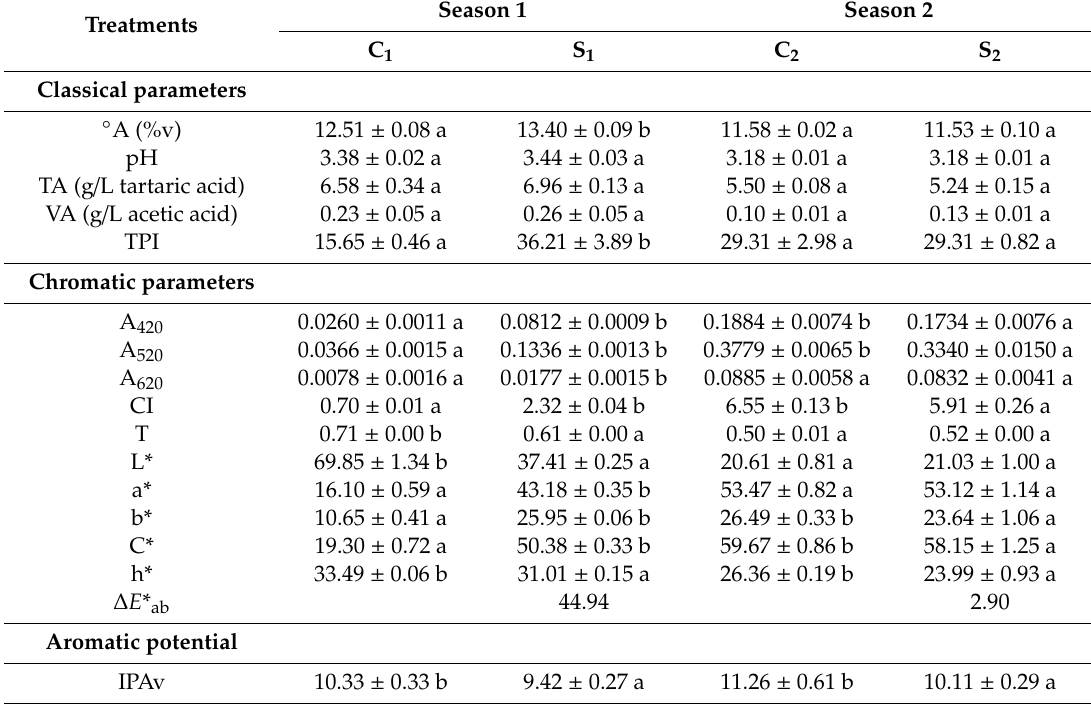
Table 1. Enological parameters including classical and chromatic parameters and aromatic potential of Bobal